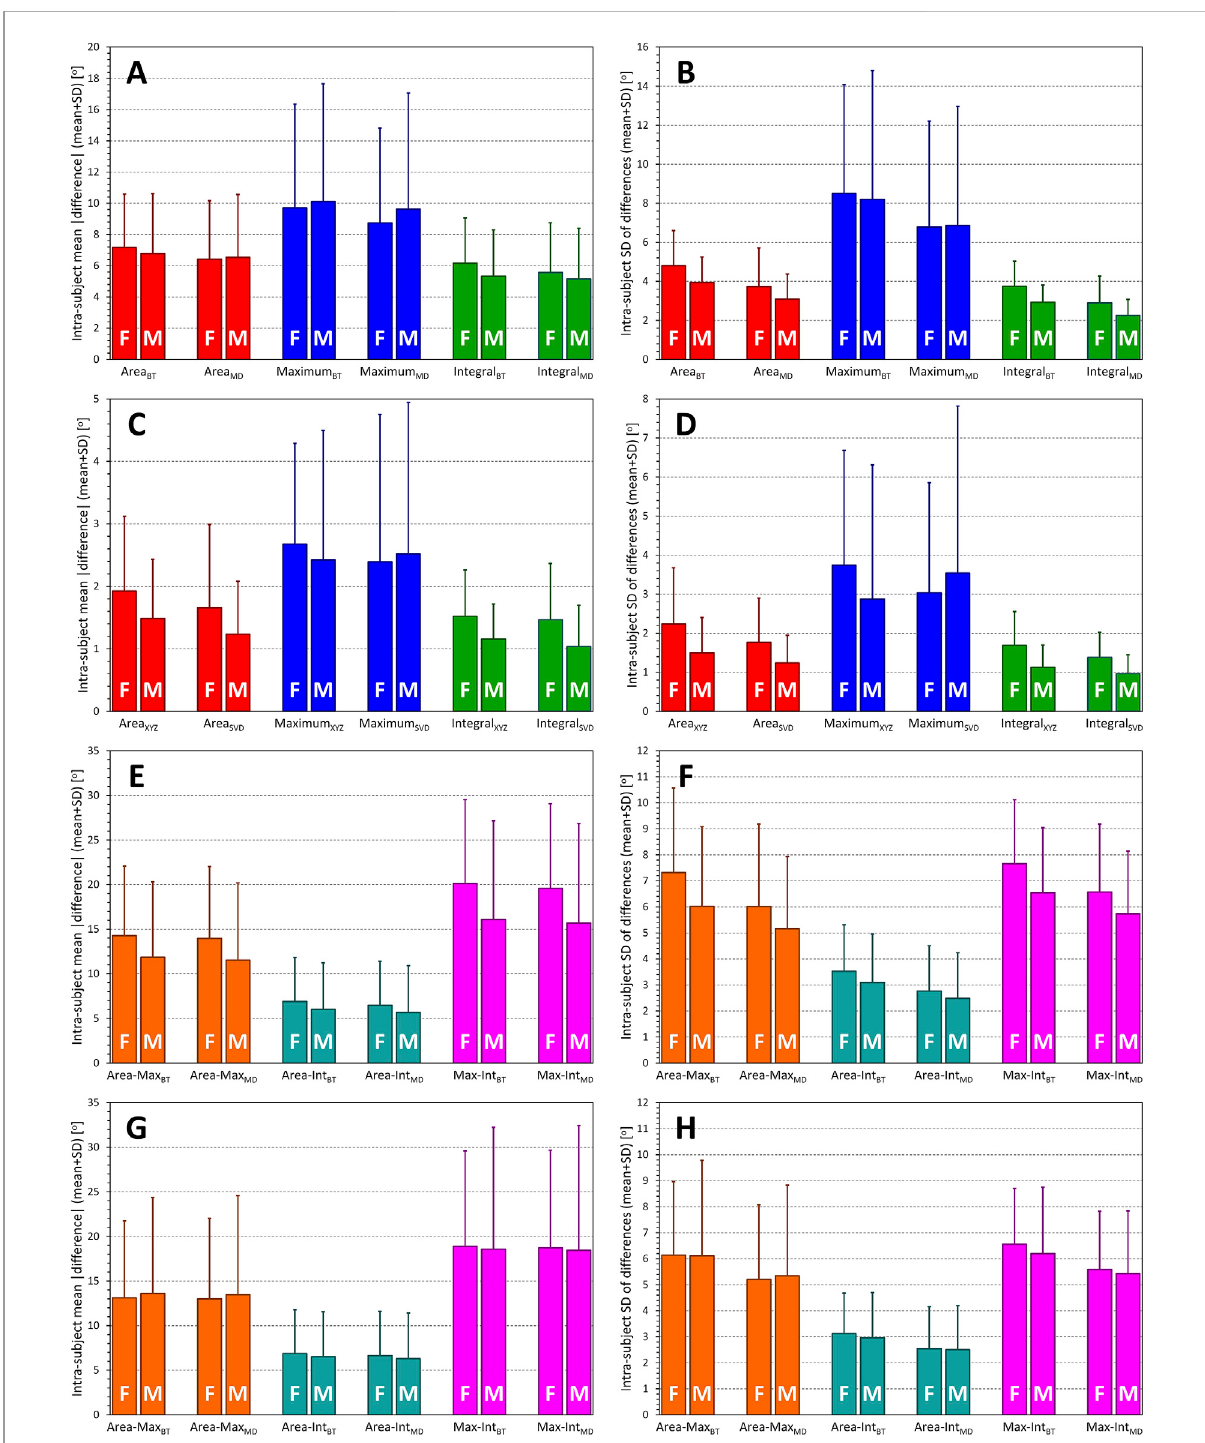
FIGURE 5 Statistical summaries of the differences between QRS-T angle measurements shown in Figures 1 – 4. Panel (A) shows the summary of intra- subject means of absolute values of the differences betweenthe angle measurements in conversion matrix-derived XYZ orthogonal leads and SVD- derived optimised orthogonal leads; panel (B) shows the summary of intra-subject standard deviations of these differences. Panel (C) shows the summary of intra-subject means of absolute values of the differences between measurements in median waveforms of an ECG segment and the averages of measurements in individual beats of the same segment; panel (D) shows the summary of intra-subject standard deviations of these differences. Panels (E) and (G) show the summary of the intra-subject means of absolute values of the differences between different